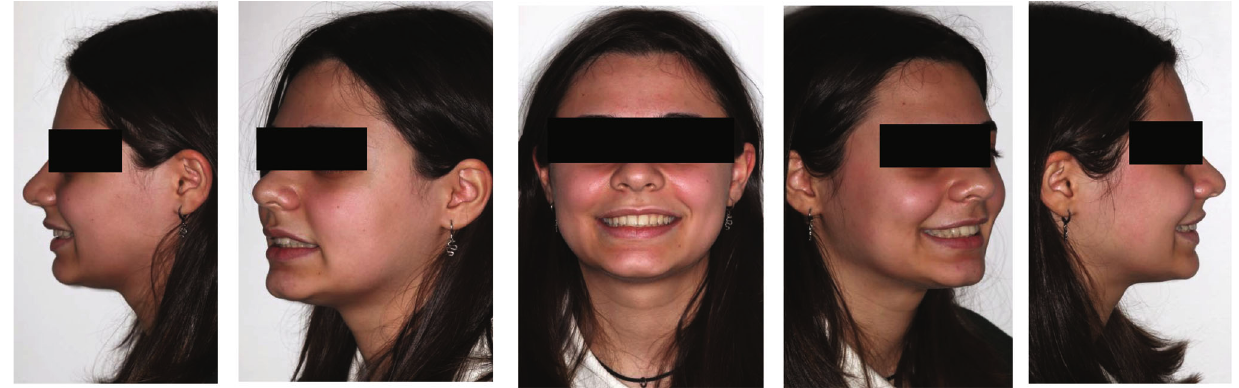
Figure 14: Final extraoral photographs with smile.